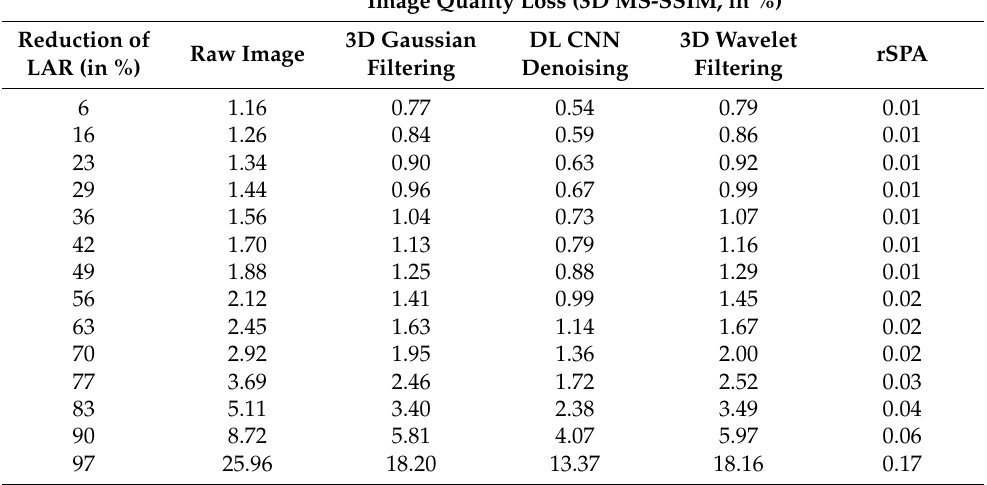
Figure 8. Comparing denoising methods with the average Multiscale Structural Similarity Index (3D MS-SSIM) for simulated thorax CT: ( A ) varying the absorbed radiation dose for a synthetic 30-year-old female patient with a water-equiv. cross-section of 27 cm; ( B ) varying the absorbed radiation dose for a synthetic 1-year-old female infant patient with a water-equiv. cross-section of 12.7 cm. Noiseless thorax CT image used as reference in this performance comparison is available at https://www.dropbox.com/s/29x0xivg8l80q10/female_lung_thorax_CT_image_section_v2.mat? dl=0 (accessed on 18 March 2022 ). Dotted lines show 95% nonparametric confidence intervals (c.i.) obtained for every value of CTDI vol from 100 different independently-generated noisy synthetic CT images, using the MATLAB function quantile() . Table 1. Deterioration of CT image quality (decrease in 3D MS-SSIM index, baseline = 100%) caused by a reduction of lifetime attributable risk (LAR) for different methods. The CT scans pertain to the infant patient, with a fixed feature contrast of 200